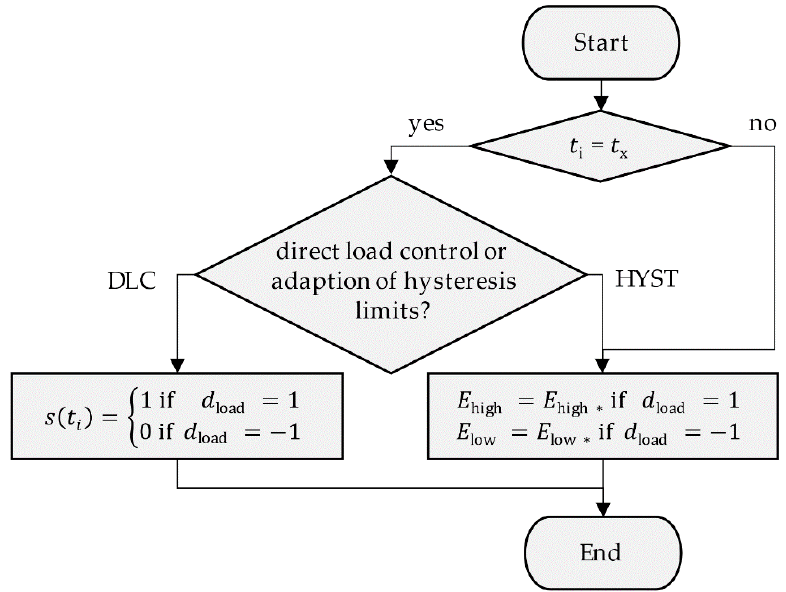
Figure 5. Program flow chart of calling a flexibility measure to calculate the flexible load profile.